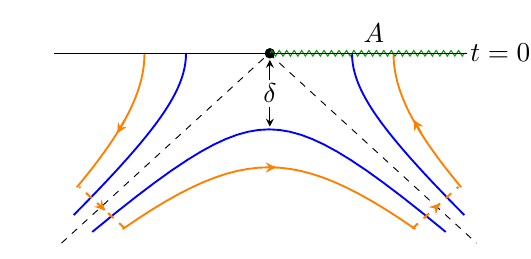
Figure 8 . Left: integration contour in the complex t t < 0 with cut-offs (blue) at Rindler radius r = δ . The t the Euclidean time domain (dashed) as it passes between wedges.